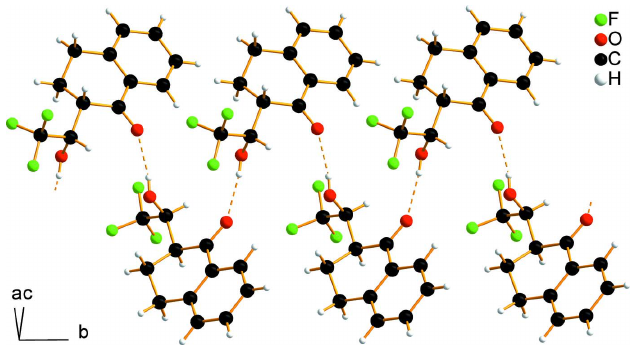
Figure 3 Packing diagrams of the title compound viewed along [100] (top), [010] (middle), and [001] (bottom).